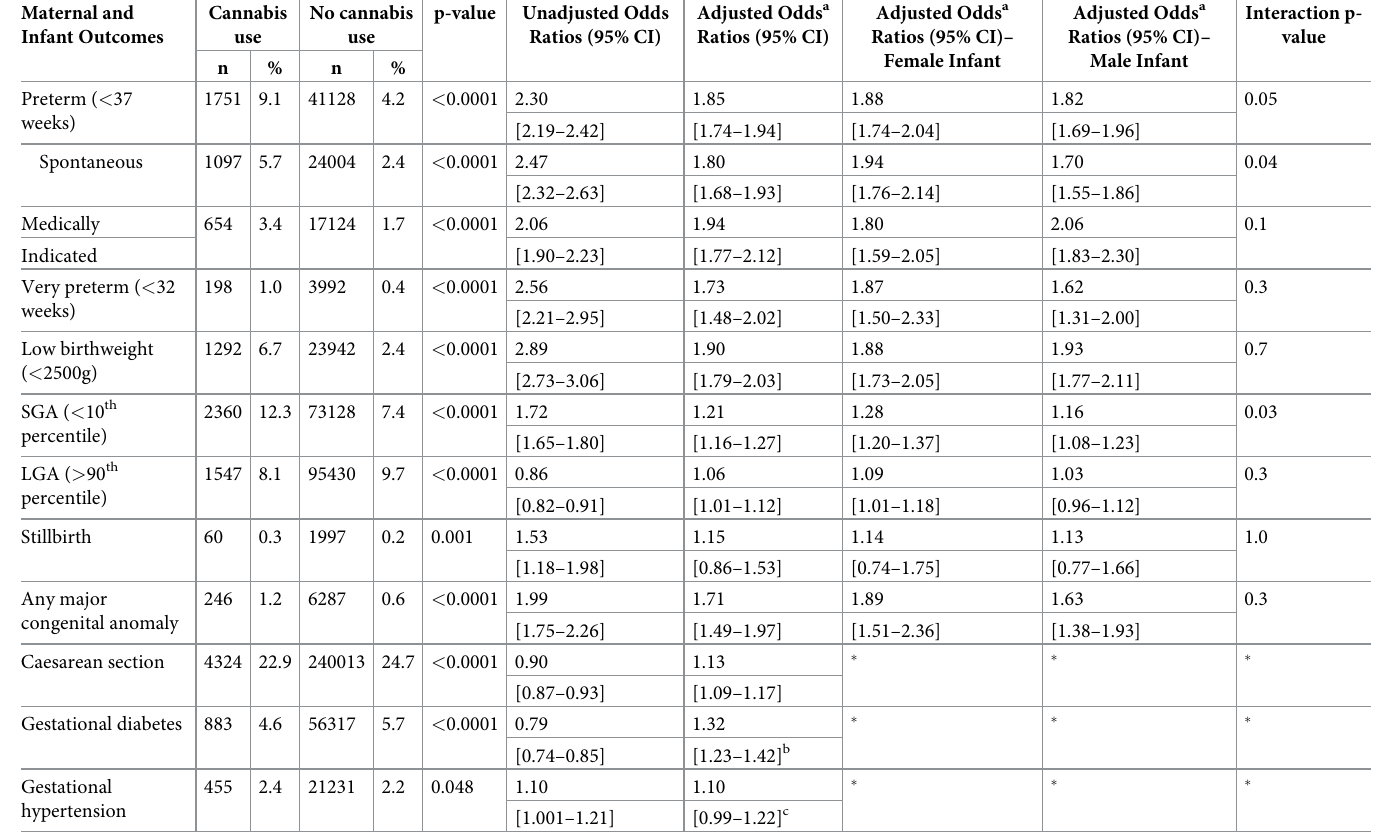
Table 2. Associations between cannabis use in pregnancy and maternal and infant outcomes, BC, ON and NL, 2012–2019. Maternal and Infant